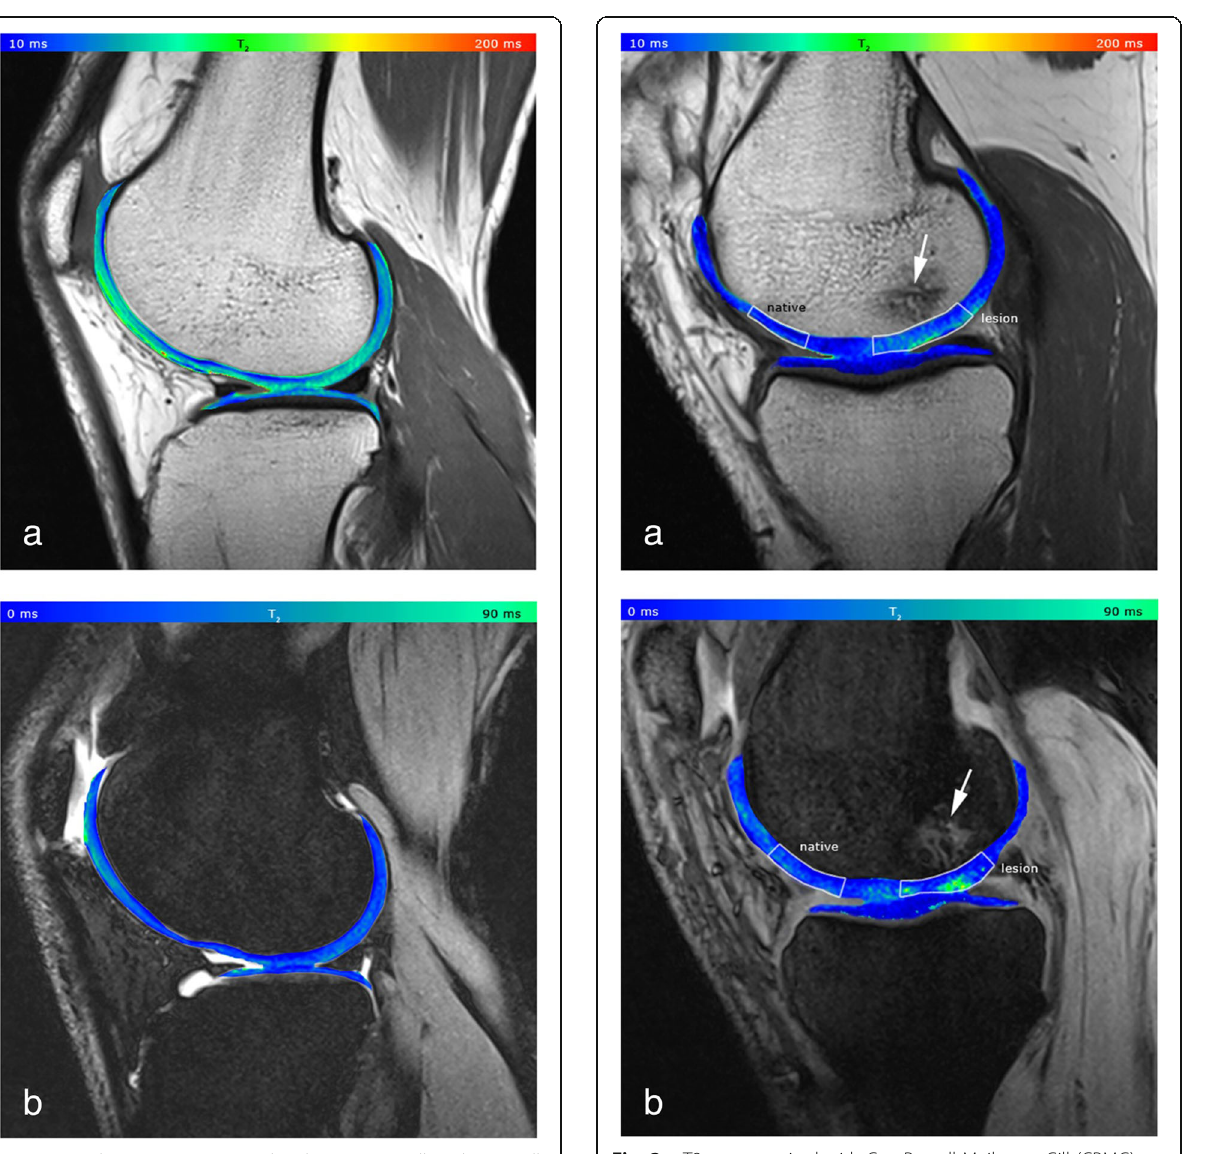
Fig. 2 a Cartilage T2 map acquired with a Carr-Purcell-Meiboom-Gill (CPMG) multi-echo spin-echo (MESE) sequence, pseudo-colour- coded and overlaid on a morphological T2-weighted image from a 32-year-old healthy volunteer (echo time 11.9 ms). b Cartilage T2 map acquired with a three-dimensional triple echo steady state, pseudo-colour-coded and overlaid on the second acquired image (F 0 , the lowest order steady state free precession — free induction decay mode acquired in the repetition time). The typical zonal stratification of cartilage is observable with both techniques. However, the CPMG sequence provides apparently higher dynamic contrast of T2 values with better depiction of cartilaginous layers. Reprinted with permission from: Juras et al., Eur Radiol 2016 (reference [21])